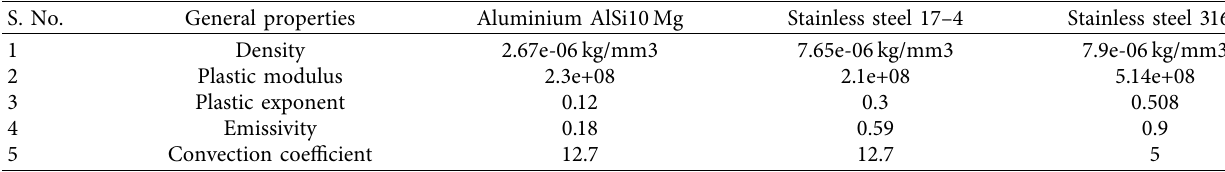
Figure 2: Design of 3-blade propeller. Table 1: General Properties of materials for 3-blade Propeller.